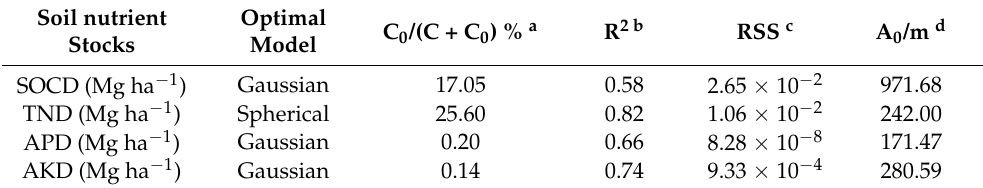
Table 2. Semi-variogram analyses of SOCD, TND, APD, and AKD at 0–60 cm. Soil